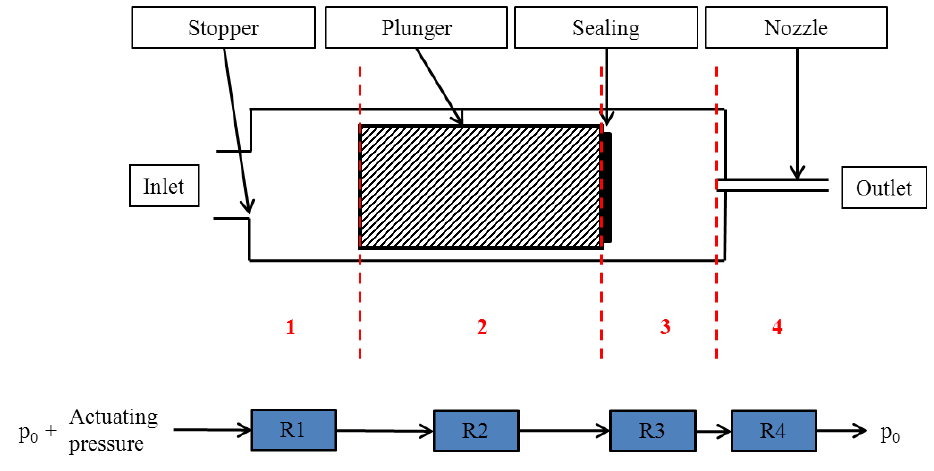
Figure 3. Scheme of the different subsections of the dispensing valve and the corresponding fluidic resistances. The total fluidic resistance equals the sum of the individual resistances R1 to